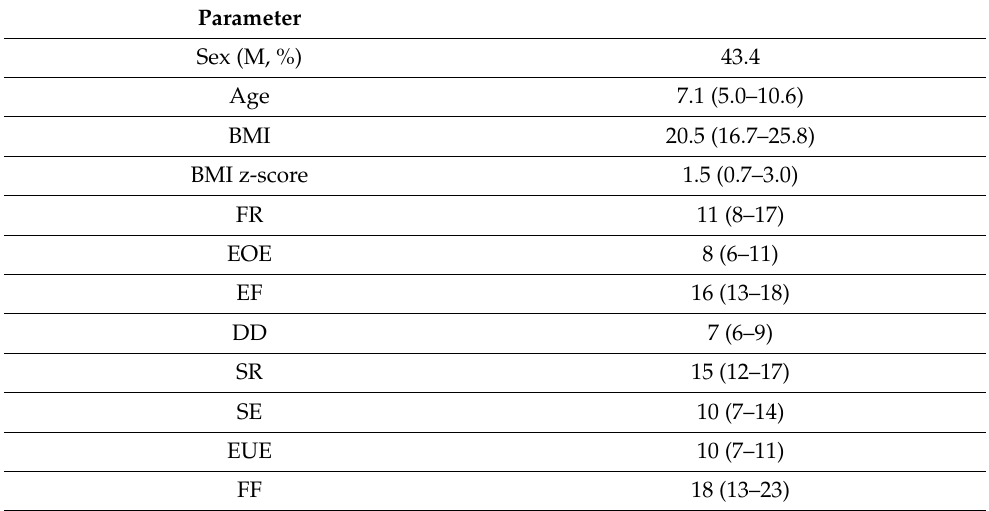
Table 1. Anthropometric and CEBQ scores of the study